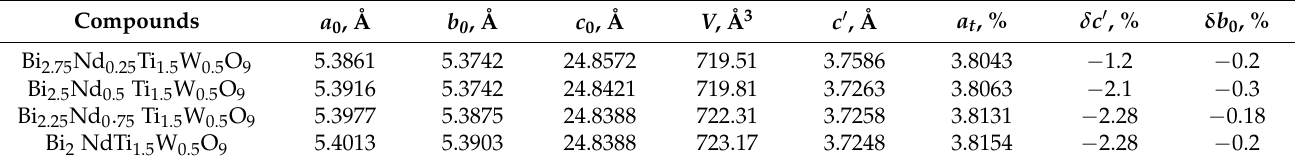
Figure 2. Experimental curve of the X-ray powder diffraction patterns of the Bi 3–x Nd x Ti 1.5 W 0.5 O 9 (x = 0.0, 0.25, 0.5, 0.75, 1.0) compounds. Table 1. Unit cell parameters a 0 , b 0 , c 0 , V , a t is the parameter of the tetragonal period, c ′ is the octa- hedron height along axis c , δ c’ is the deviation of the unit from the cubic shape, δ b is the rhombic distortion.